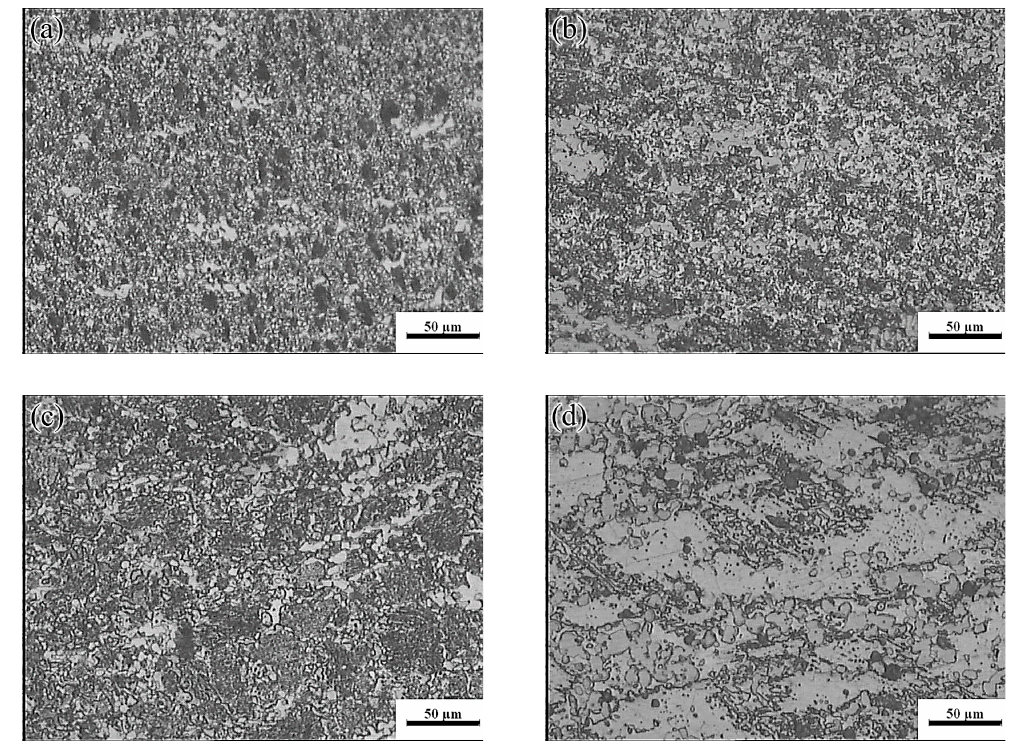
Figure 21. Microstructures of Mg-16Al Mg alloy in INS: ( a ) 523 K / 0.0001 s − 1 , ( b ) 573 K / 0.0001 s − 1 , ( c ) 623 K / 0.0001 s − 1 , and ( d ) 673 K / 0.0001 s − 1 .